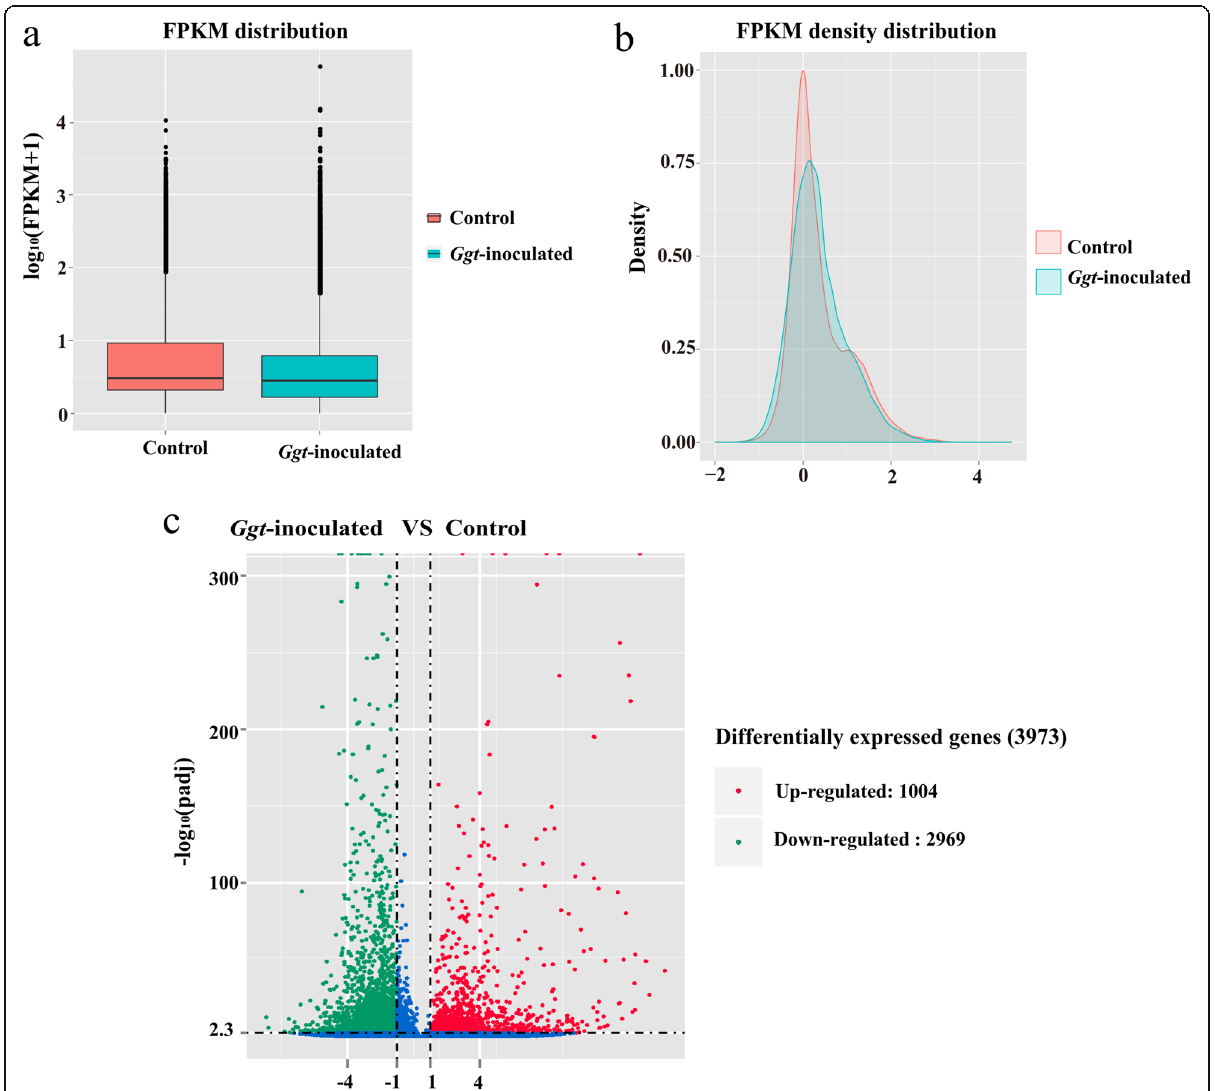
Fig. 3 Gene expression comparisons between Ggt -inoculated and control wheat groups, and hierarchical clustering analyses of DEGs. a Boxplot showing the overall expression levels of samples. The box represents 50% of the FPKM, and the y-axis corresponds to samples ’ log 10 (FPKM+ 1). b FPKM density distribution of samples. The y-axis corresponds to gene density, and the x-axis displays the log 10 (FPKM) of samples. c Volcano of DEGs between Ggt -inoculated and control wheat roots. The y-axis corresponds to the mean expression value of log 10 ( p -value), and the x-axis displays the log 2 fold change value. The red dots represent up-regulated DEGs, and the green dots represent down-regulated